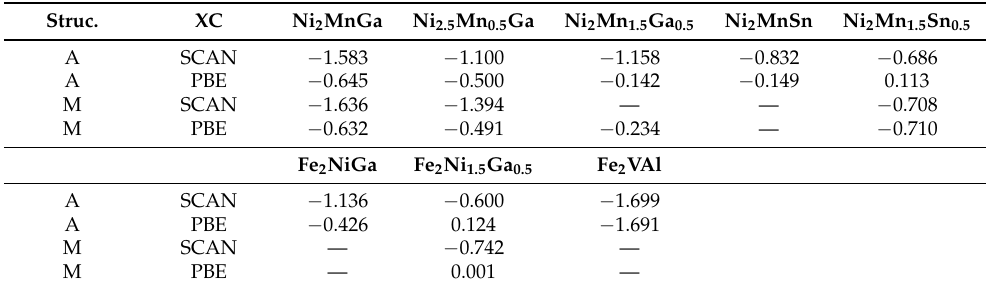
Table 2. Calculated E form (in eV/f.u.) within PBE and SCAN for the cubic austenitic (A) and tetragonal martensitic (M) phases of Ni-Mn-(Ga, Sn), Fe-Ni-Ga, and Fe-V-Al [54]. Missing values indicate the unfavorability of the martensitic structure with respect to the cubic one. Struc. XC Ni 2